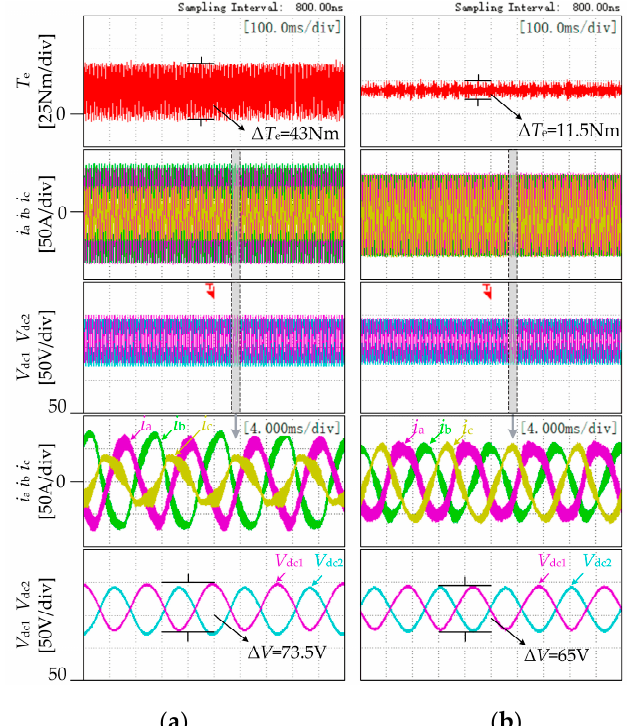
Figure 9. Experimental results at 1500 r/min and 20 Nm: ( a ) without capacitor voltage offset suppression; ( b ) proposed method .